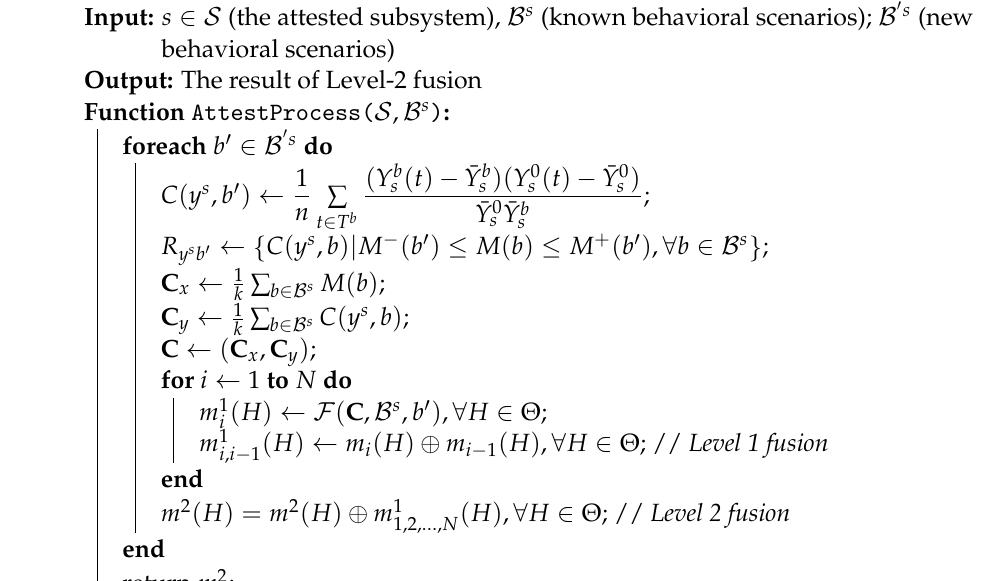
Algorithm 1: Attestation procedure including Level 1 and Level 2